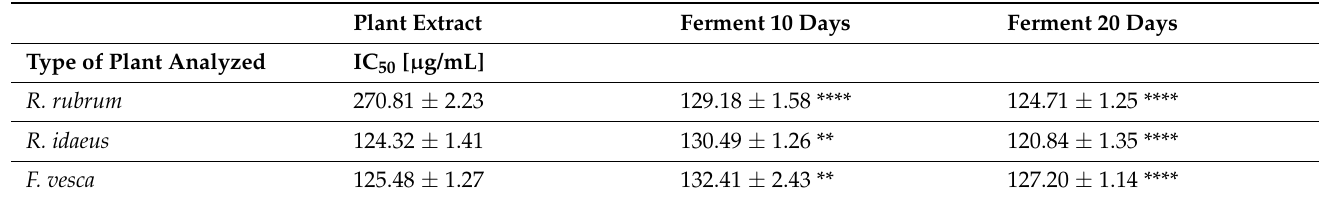
Table 4. Values of IC 50 of ABTS+ radical scavenging for R. rubrum , R. ideaus , and F. vesca extracts and kombucha ferments after 20 min of exposure. Values are means ± standard deviation (SD) of